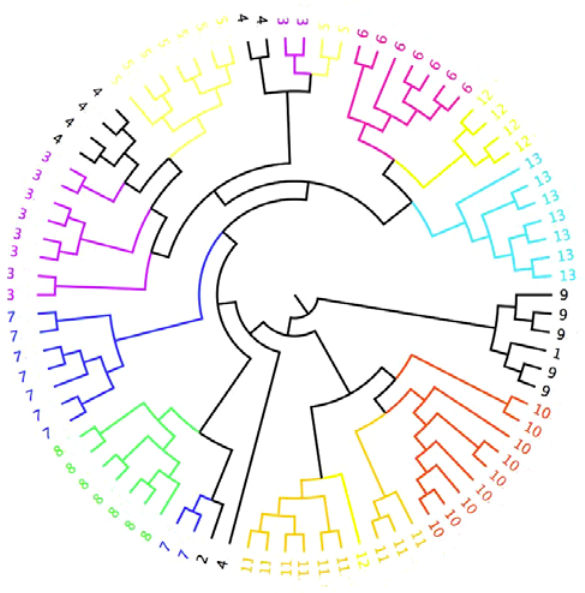
Figure 1. NJ dendrogram of Ziziphus jujuba specimens showing genetic differences of the studied